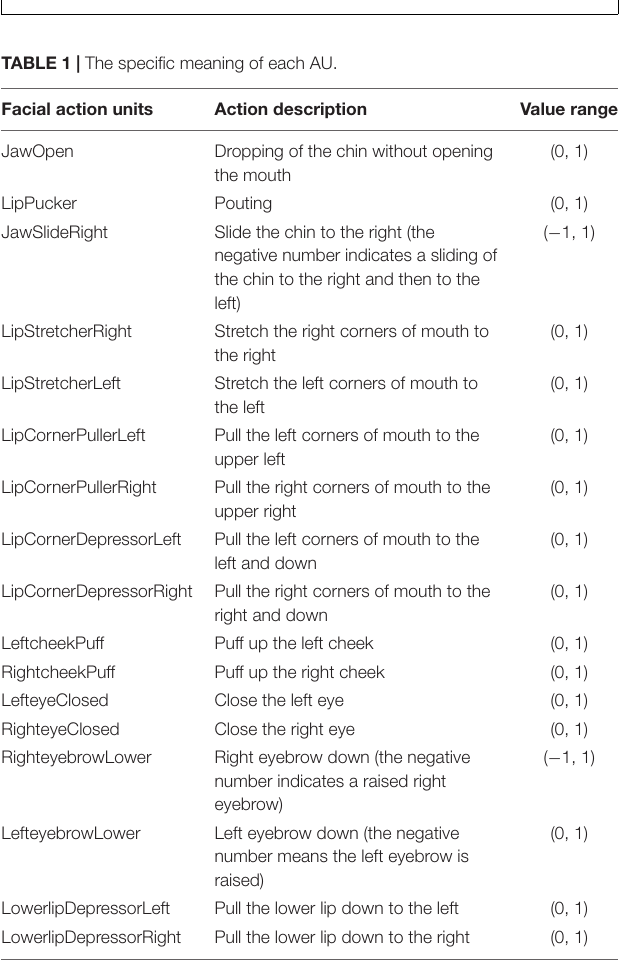
FIGURE 1 | The Kinect camera and a brief introduction about its main components.